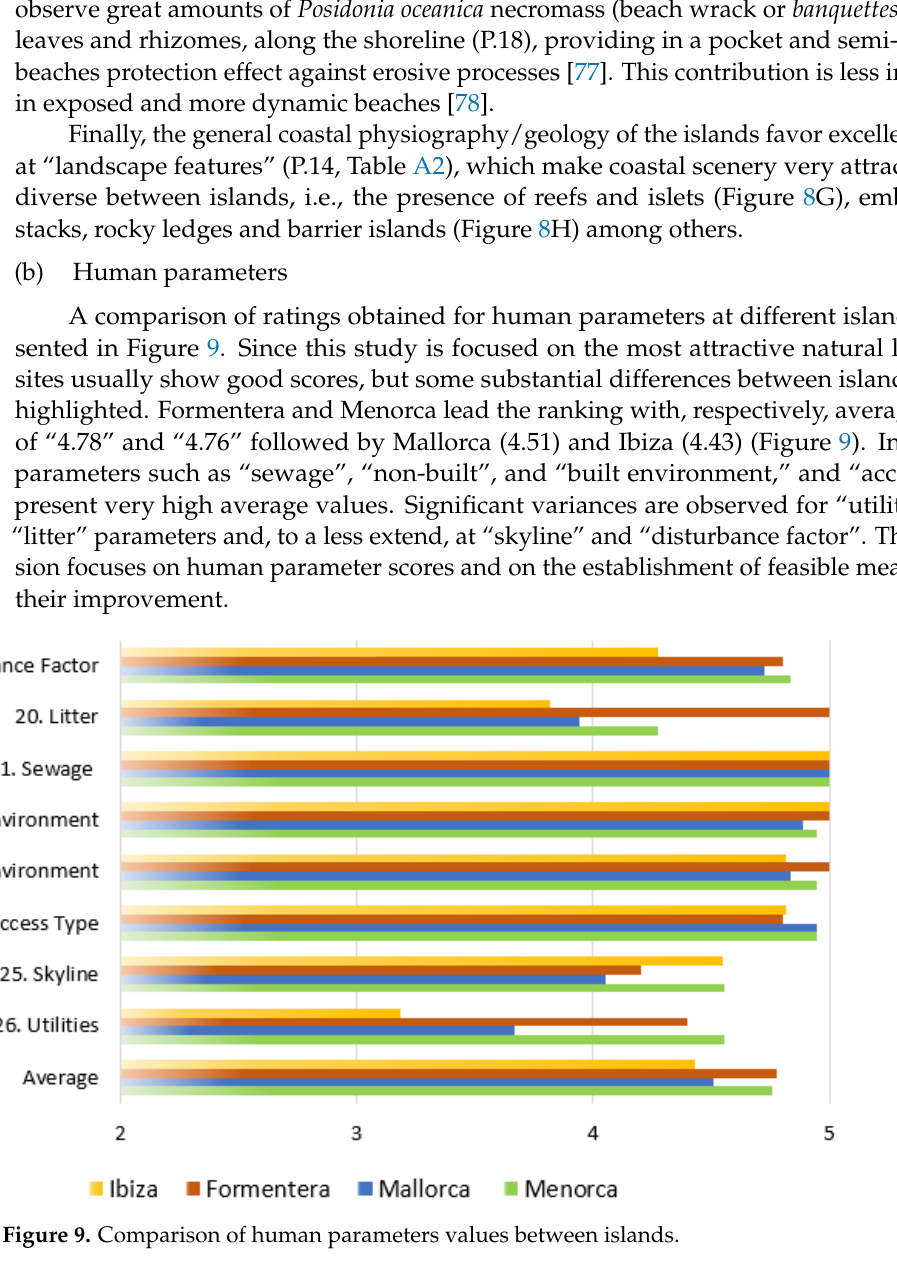
Figure 8. Natural scenic characteristics: fixed dunes and natural coastline of S’Arenal d’en Casat, Mallorca ( A ); moun- tainous landform at Cala Tuent (Puig-Major on the left), Mallorca ( B ); contrast of colors at Cala del Pilar, Menorca ( C ); cliff at Cala Llucalari, Menorca ( D ); sediment colors at Son Saura (Menorca) ( E ) and Cala Boix (Ibiza) ( F ); presence of reefs and islets at Calas Salairó and Pregonda, Menorca ( G ); narrow barrier island, Punta Alta, Formentera ( H ).